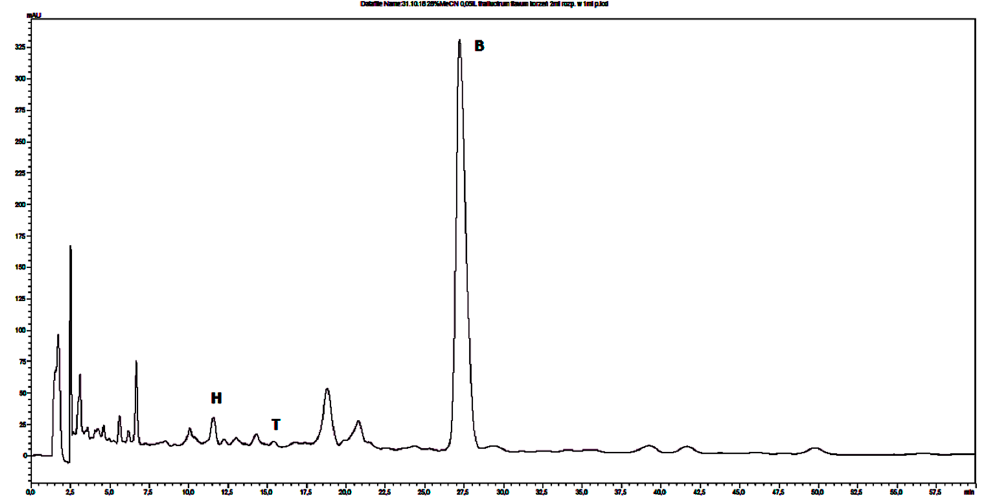
Figure 2. Chromatogram obtained for Thalictrum foetidum root extract obtained on Polar RP column with mobile phase containing 28% MeCN, water and 0.04 ML − 1 IL. Abbreviations: H-hernandezine, T-tetrandrine, B-berberine.